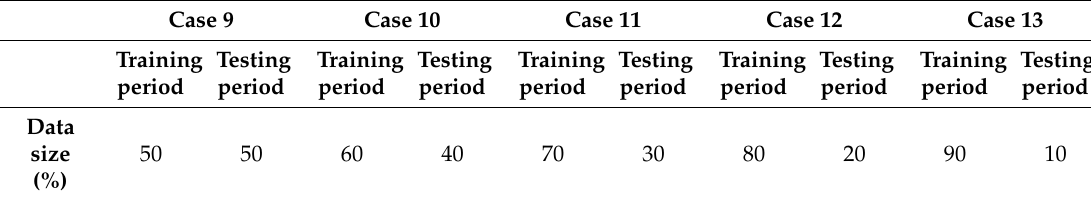
Table 7. Conditions for training and testing data size.